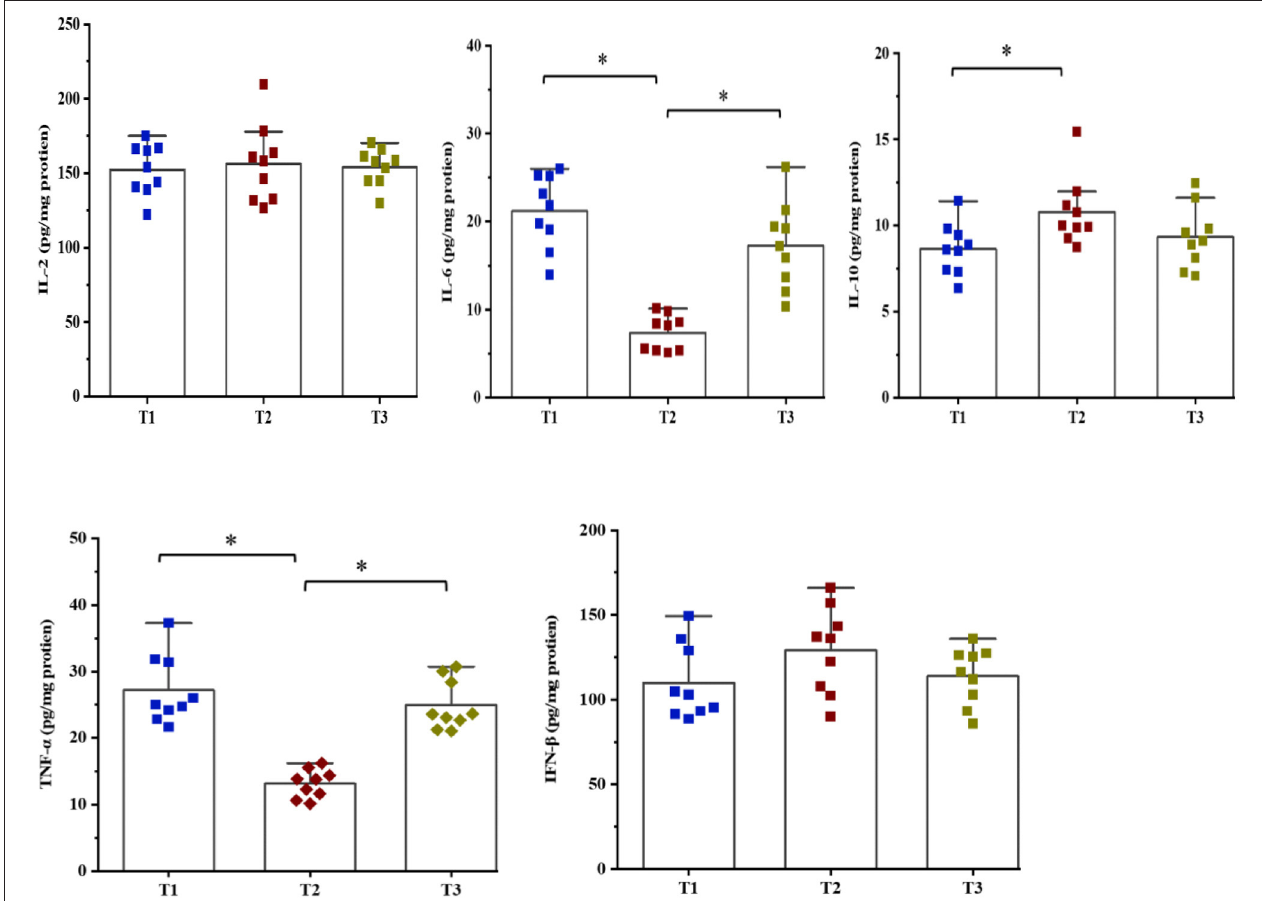
FIGURE 2 | Effects of dietary amylose/amylopectin ratio on cecal cytokines concentrations (pg/mg protein). Values are expressed as means ± SEM indicated by vertical bars. *Significantly different means ( P < 0.05). T1 (normal corn 100%, high amylose corn 0%); T2 (normal corn 50%, high amylose corn 50%); T3 (normal corn 0%, high amylose corn